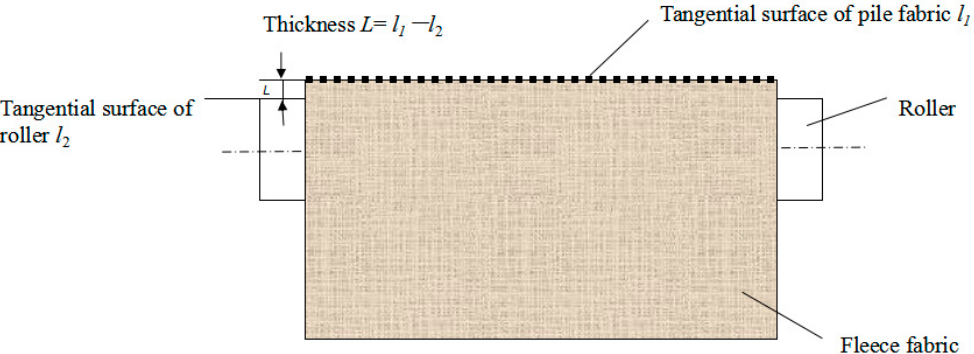
Figure 4. Solving principle of fleece fabric thickness measurement.